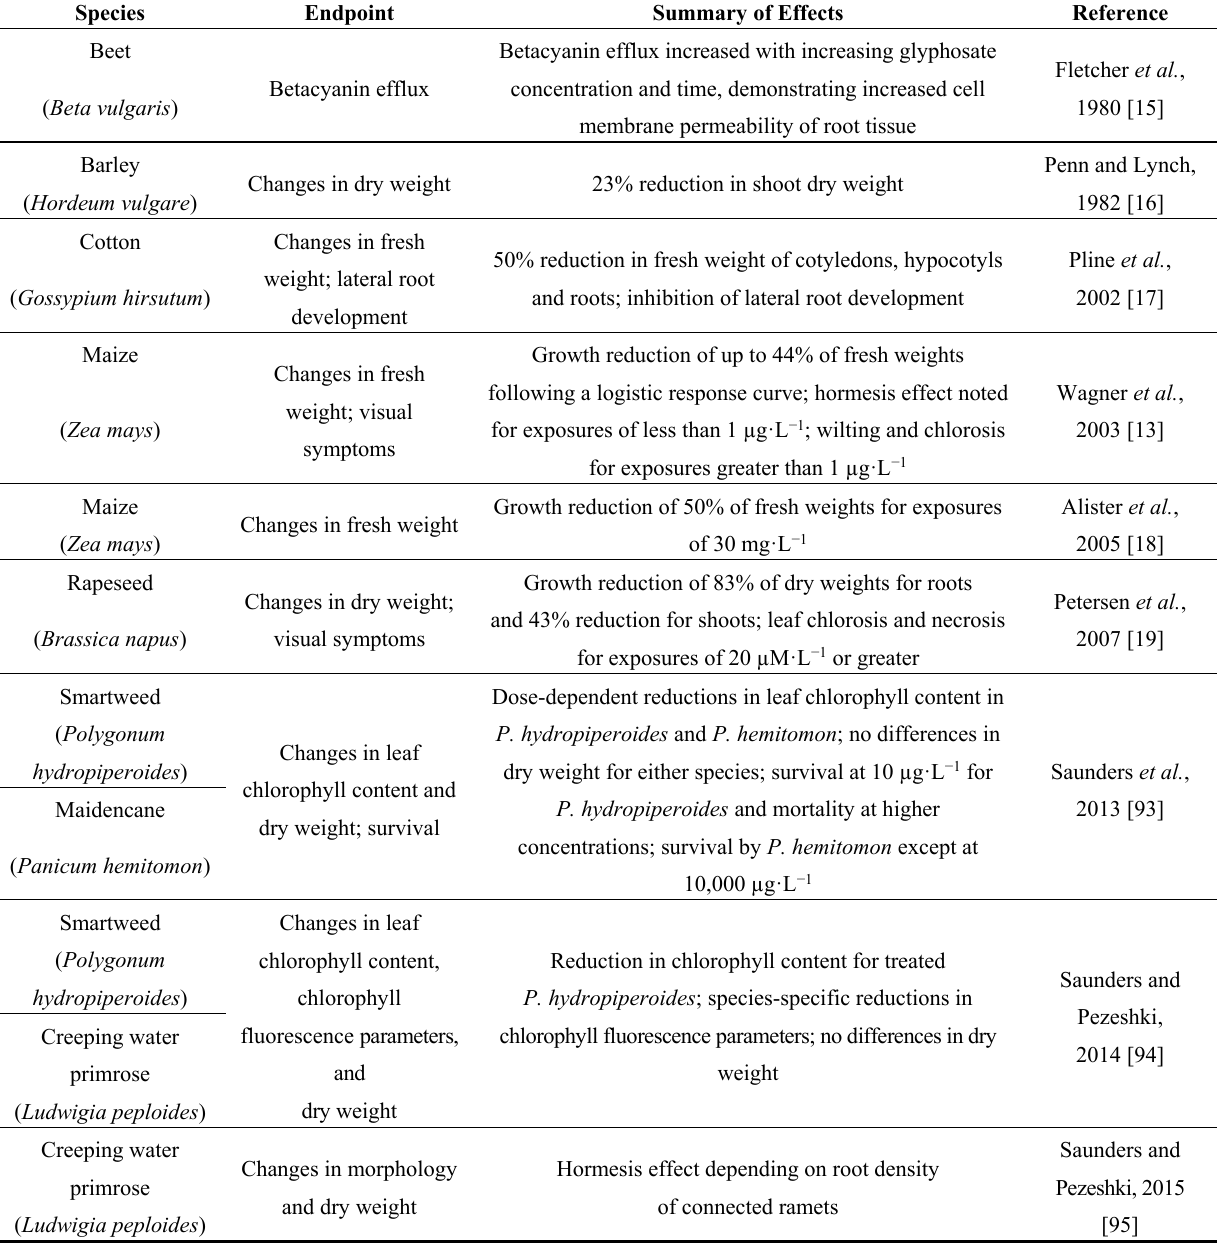
Table 5. Summary of studies investigating the effects of root-zone glyphosate